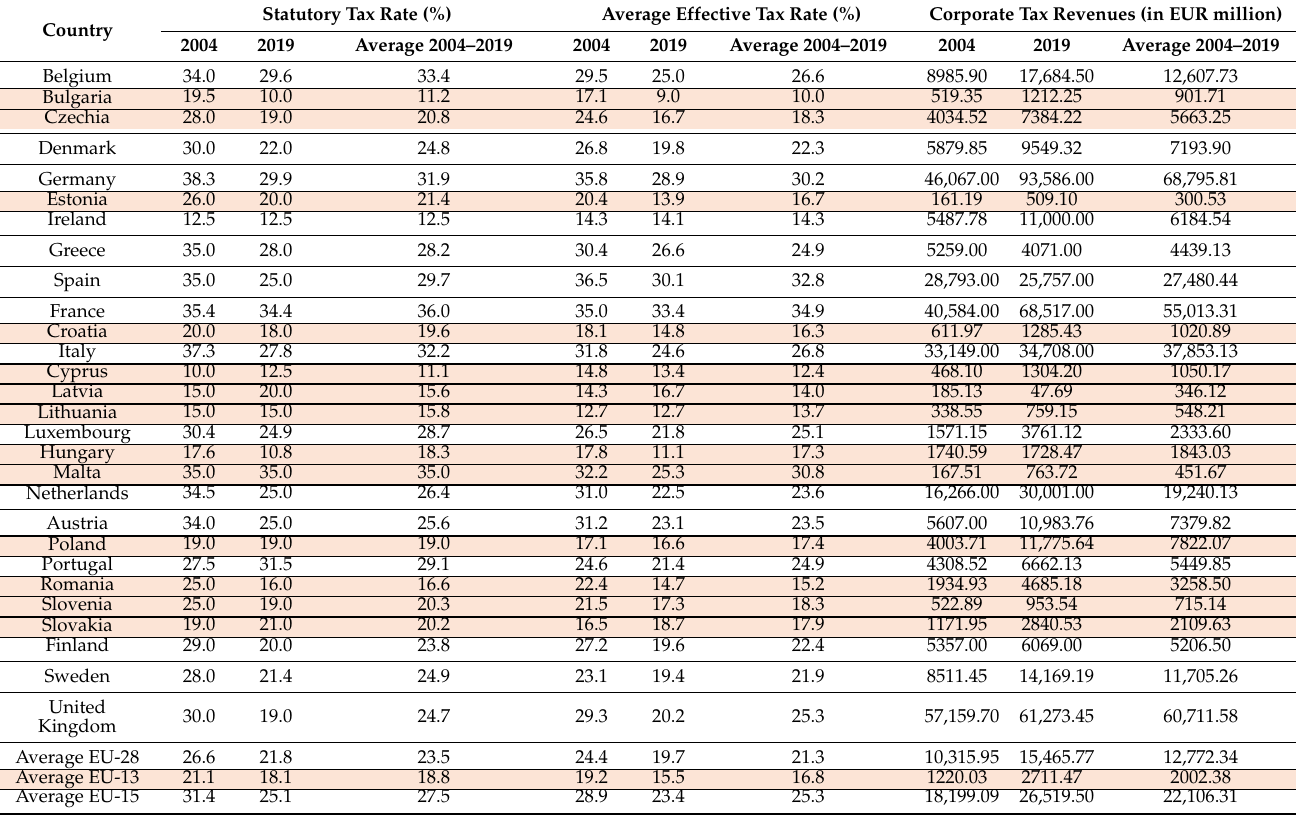
Table A1. Values of statutory, average effective tax rate and corporate tax revenues in EU